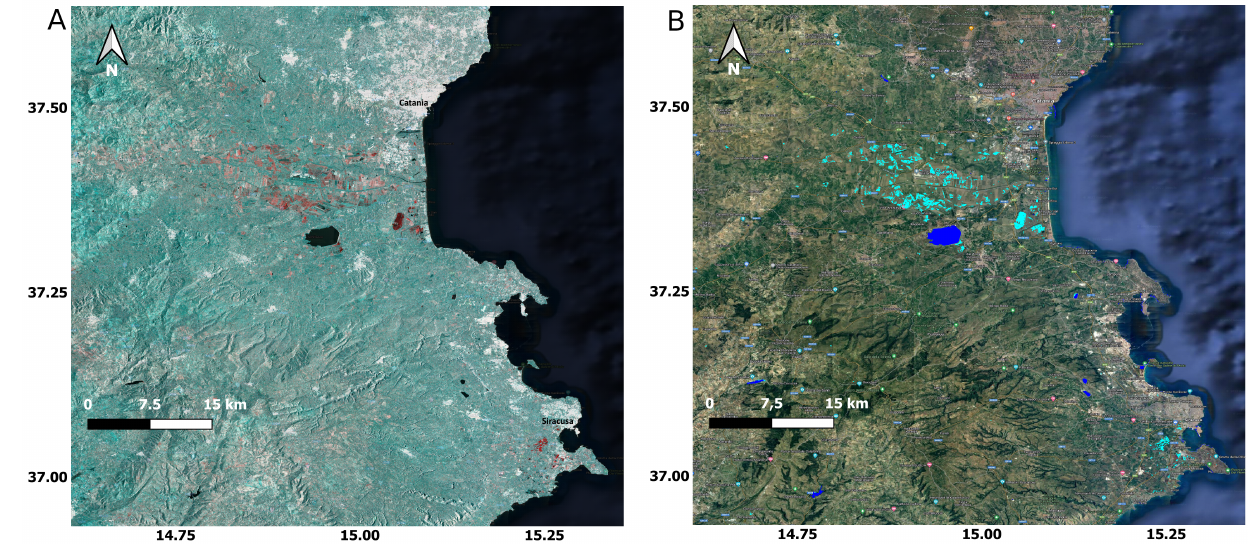
Figure 10. Panel ( A ): RGB false color image produced using the S1 data acquired on 19 October 2021 (red) and 31 October 2021 (green/blue). Panel ( B ): Flooded areas map generated by AUTOWADE using the S1 images shown in Panel ( A ). Cyan: floodwater; blue; permanent water.